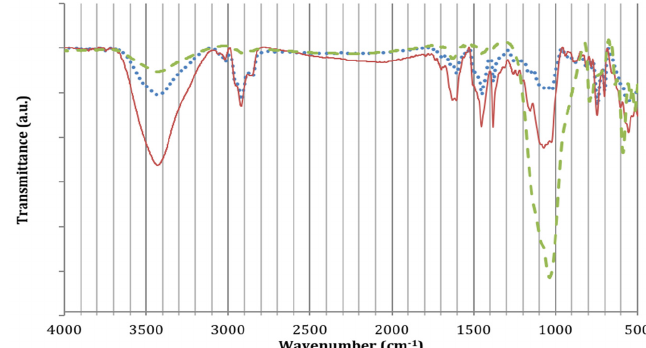
Figure 13. Infrared spectra (4000–400 cm − 1 ) of metallic (silver) graffiti on granite in the accelerated ageing induced by Na 2 SO 4 salt cycles. The dotted blue line of the spectrum corresponds to the beginning of the treatment, the dashed grey line to the 7th cycle and the continuous orange line to the 14th cycle.